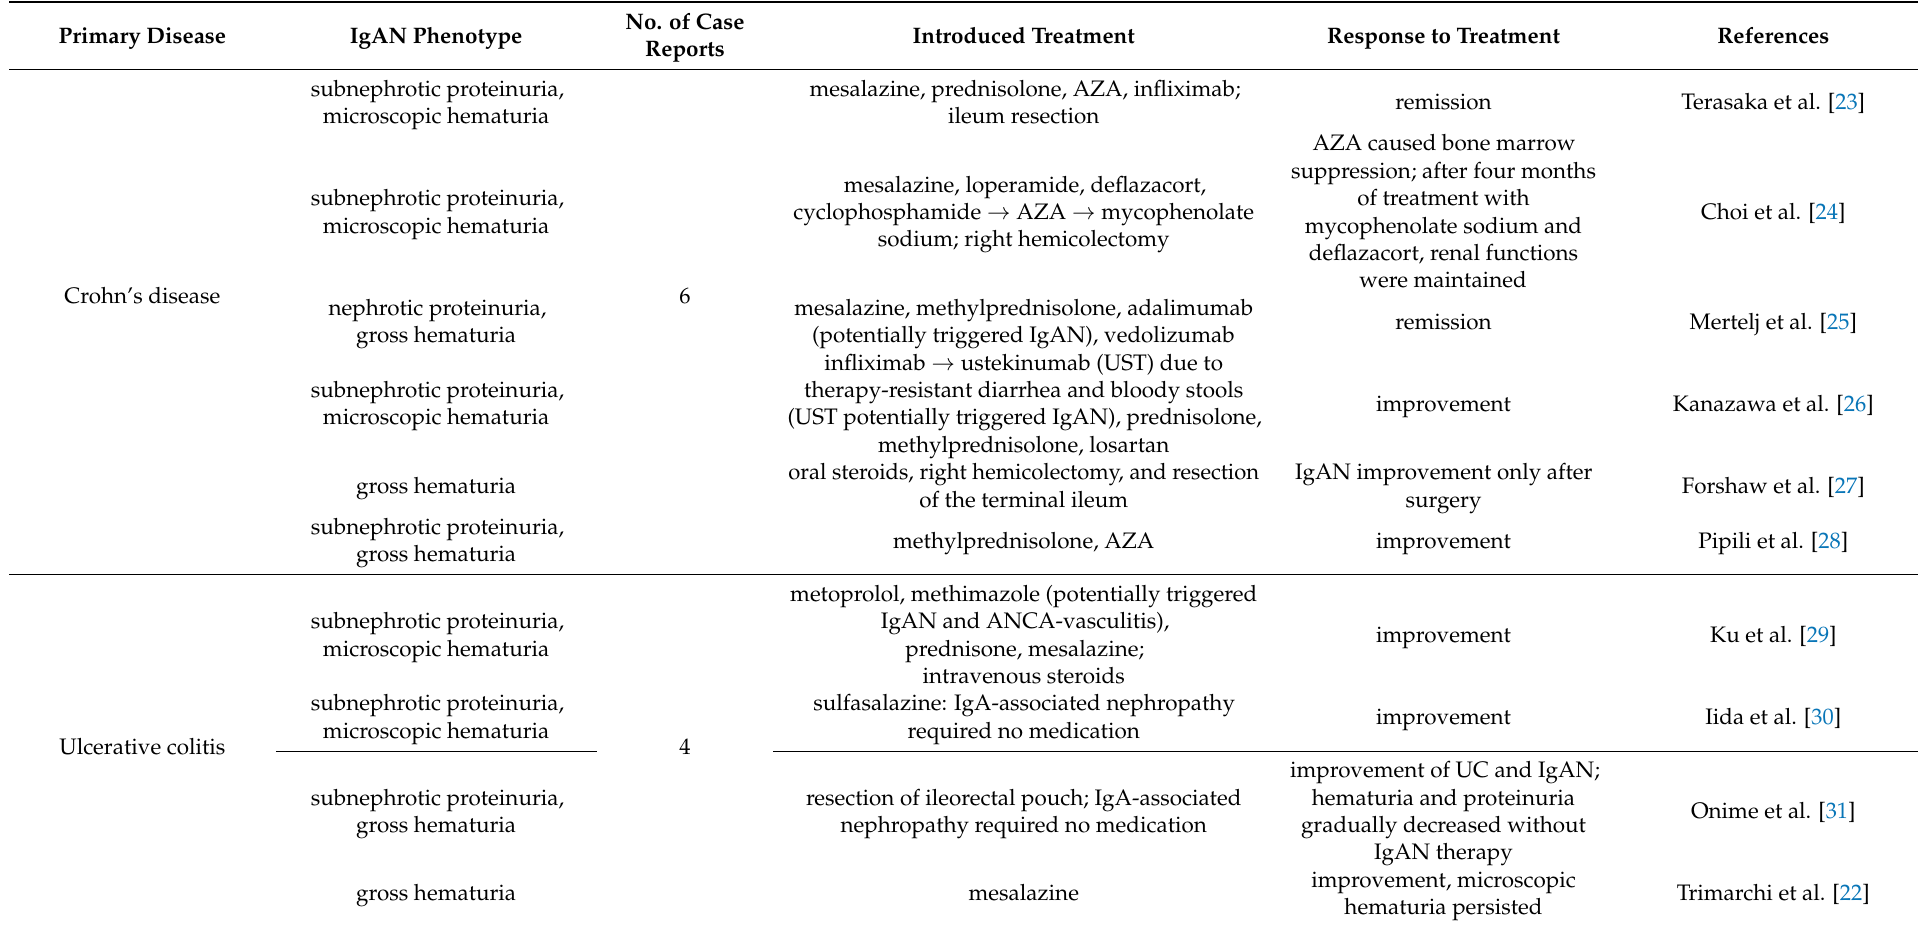
Table 1. Summary of case reports on sIgAN and IgA-associated